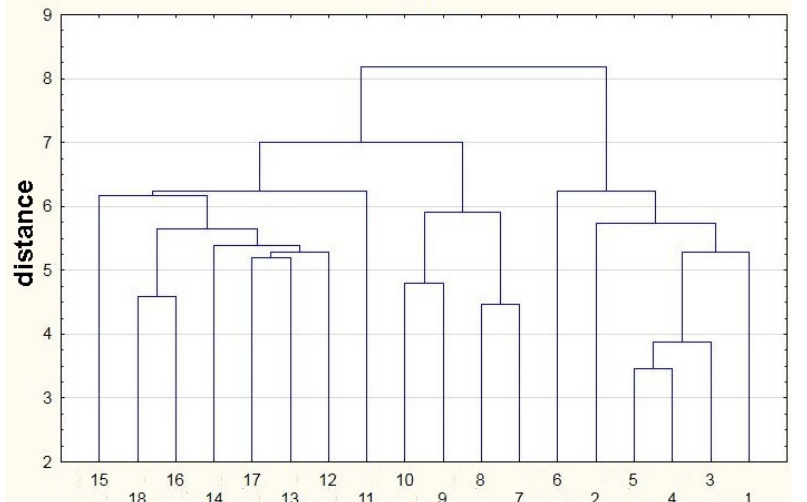
Figure 7. Cluster diagram of single-linkage (nearest neighbor) clusters for samples of agricultural distillates; points: 1–6—high quality class distillates (green),